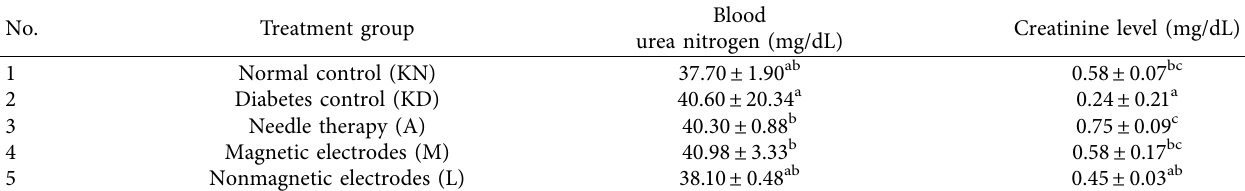
Table 2: Renoprotection efect electrical stimulation therapy for blood urea nitrogen (BUN) and creatinine levels.